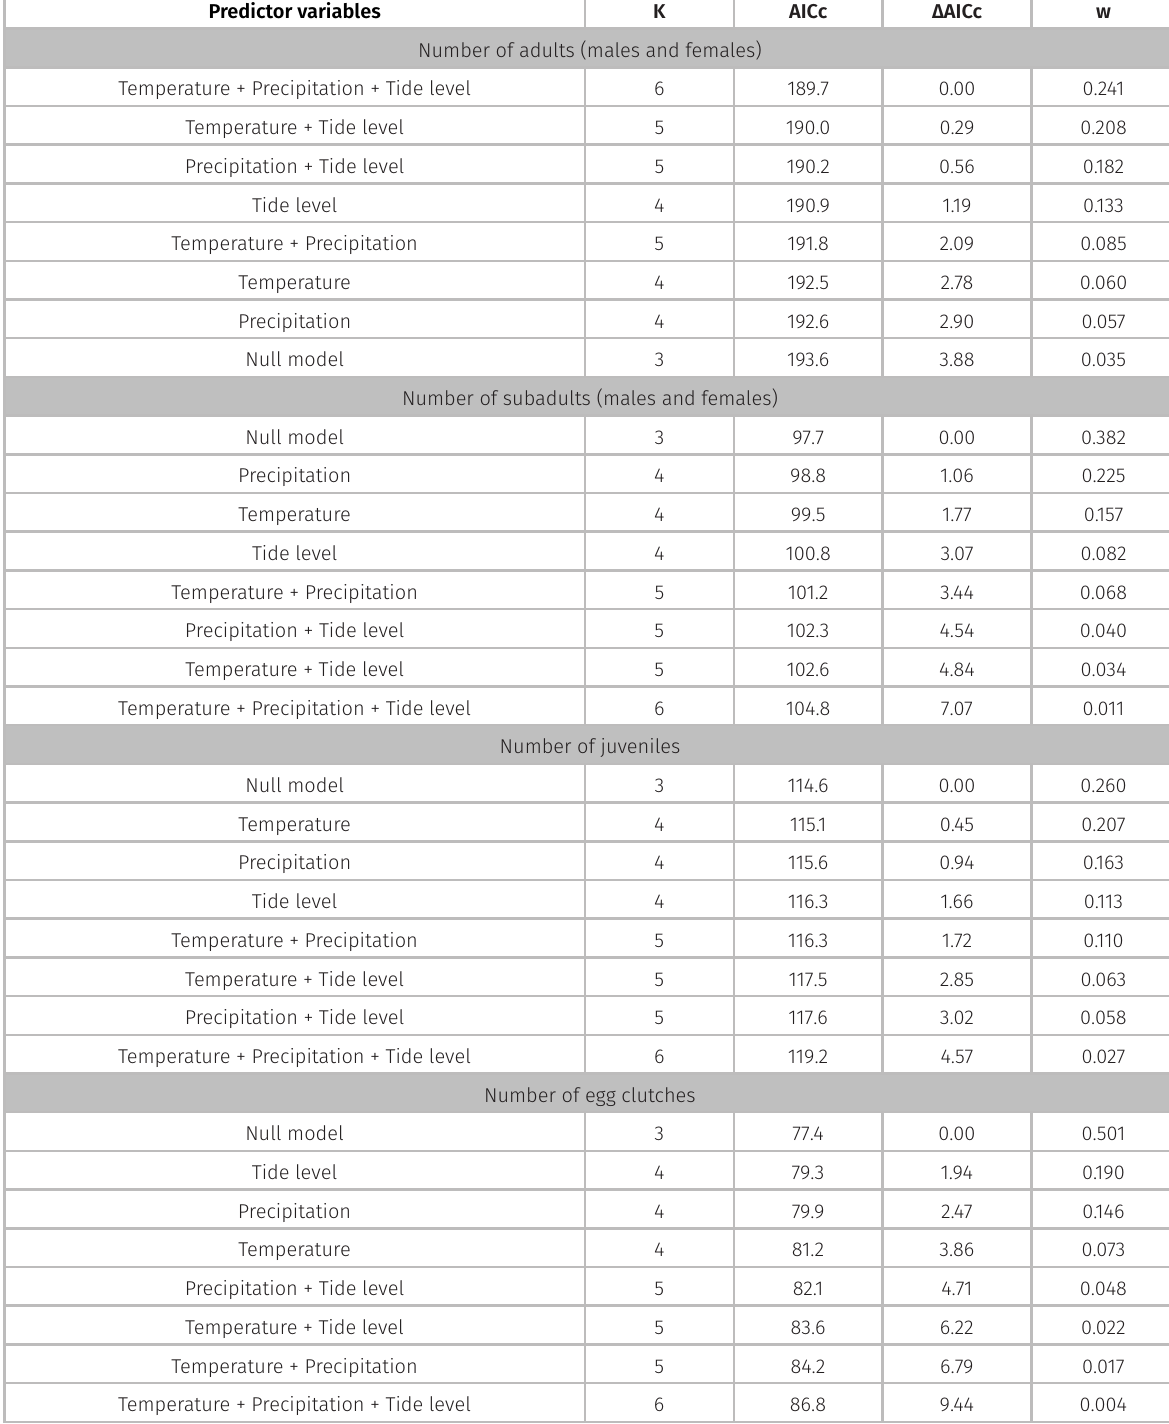
Table I. Best models to predict the number of adults, subadults, juveniles, and egg clutches of the harvestman Discocyrtus prospicuus in a tidal freshwater wetland from